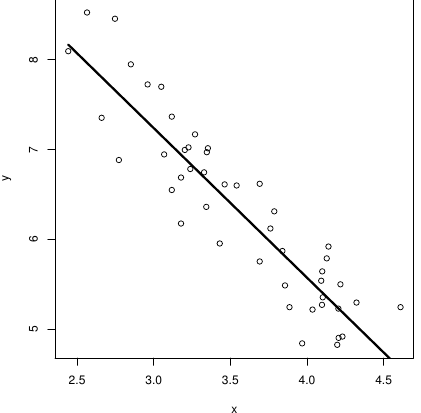
Figure 4. Plot of Y against X, TN model (black solid